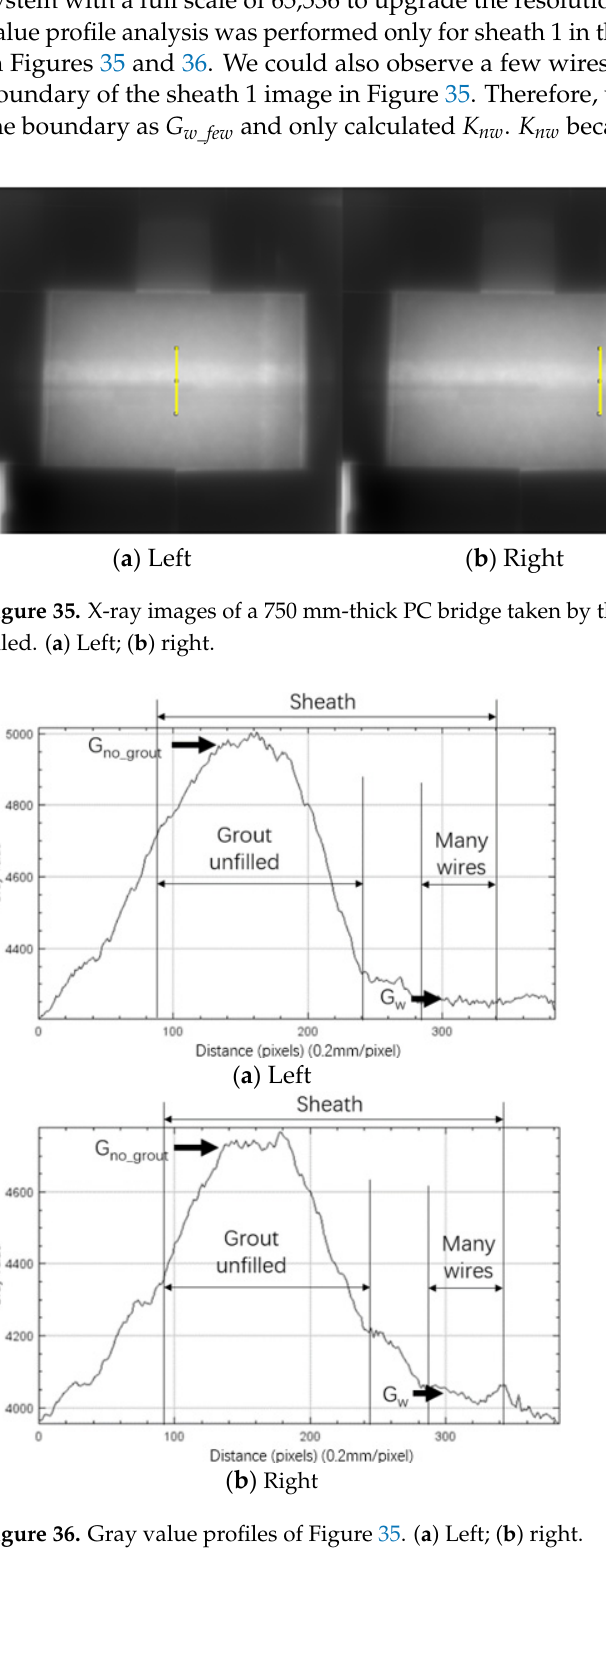
Figure 34. Photograph and X-ray image by 3.95 MeV X-ray source for 750 mm thick model sample for box-shape PC girder bridge. There are three sheaths. ( a ) Horizontal shot. The three sheaths are overlapped and only Sheath 1 can be seen. ( b ) Declined downward X-ray shot to shift the three sheaths at the FPD.